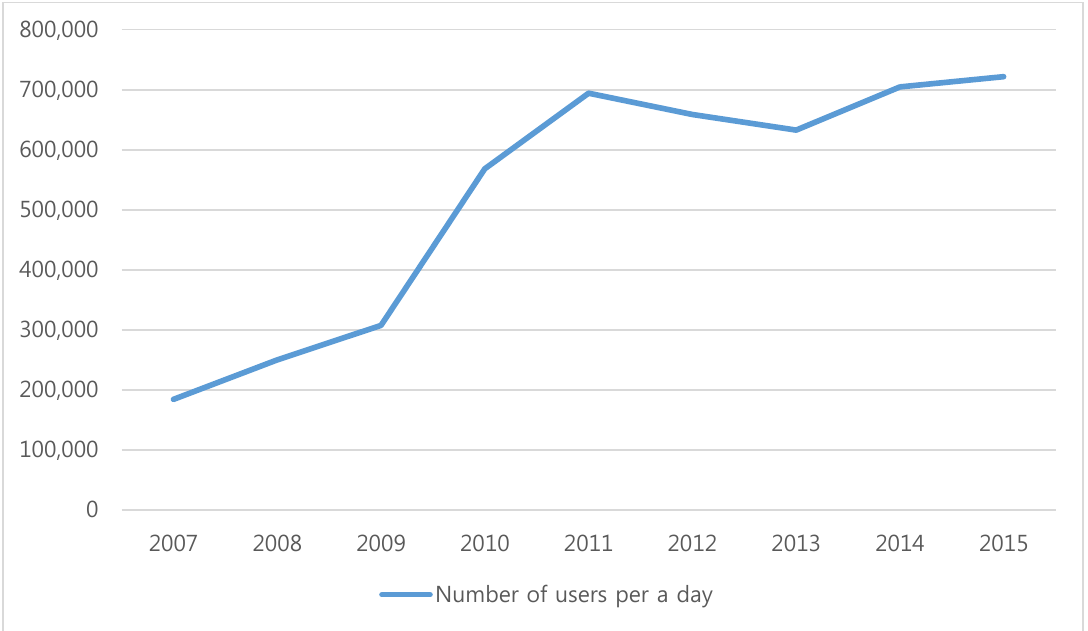
Figure 1 . Number of EBS video lecture users, Ministry of Education South Korea